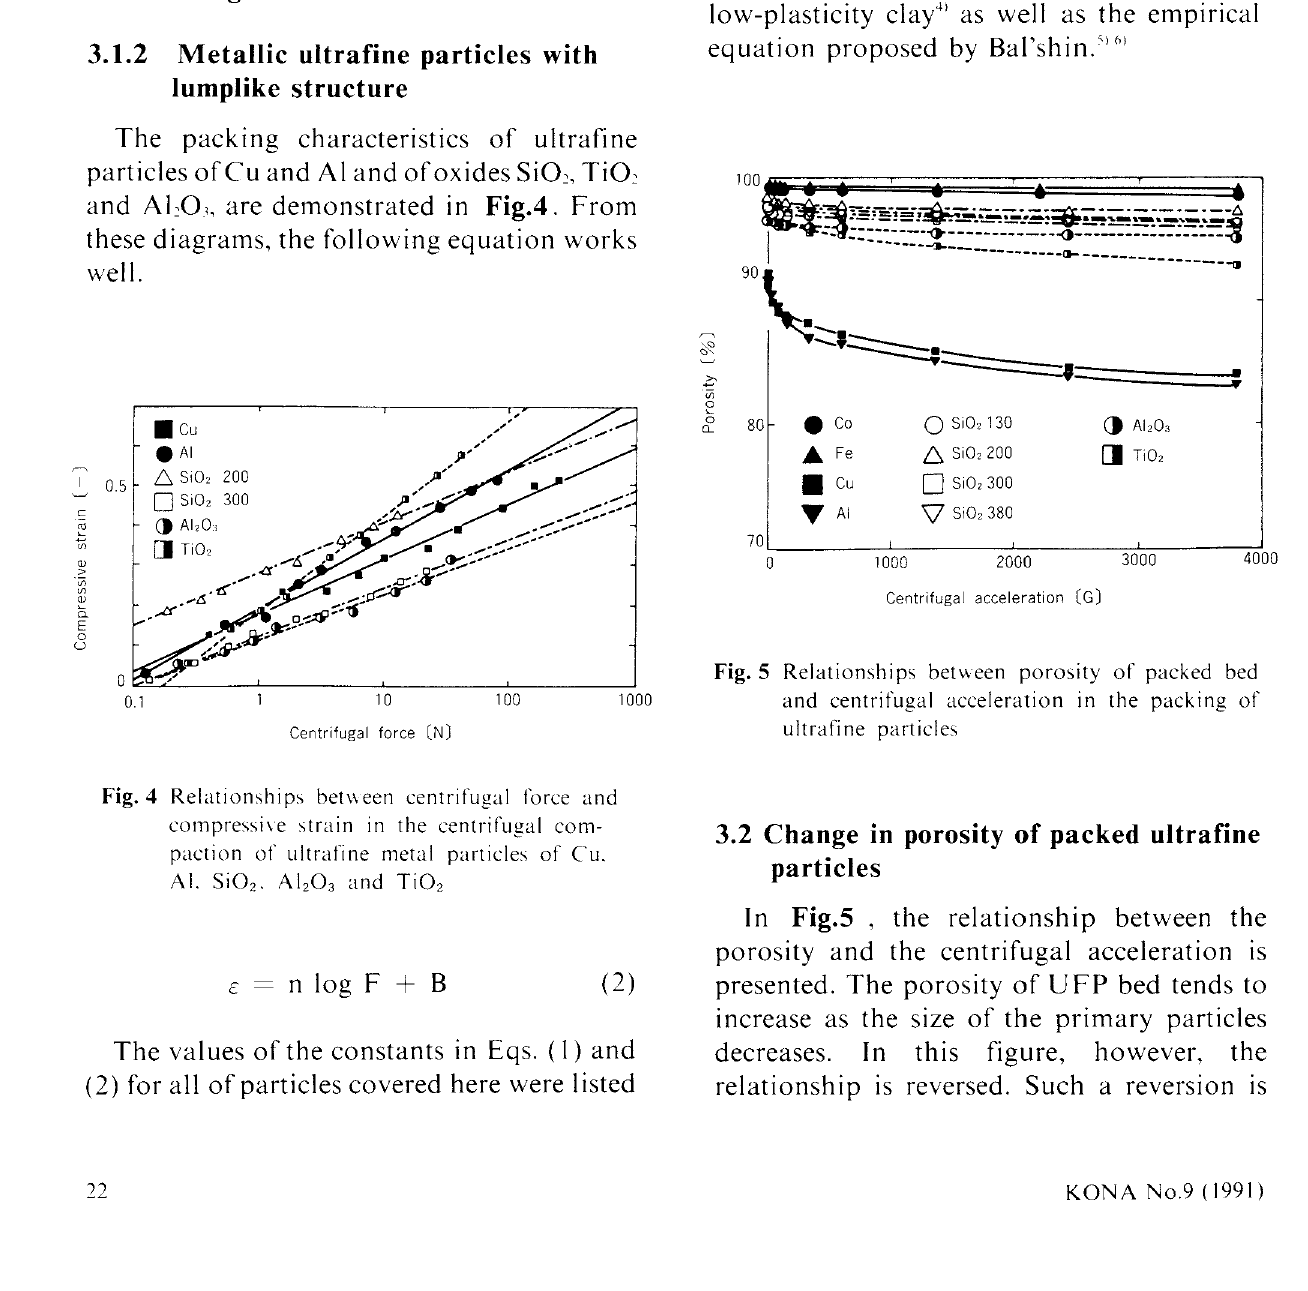
Fig. 3 Relationships het\\een centrifugal force and compressi\e strain in the centrifugal com paction of ultrafine metal particles of Co and Fe